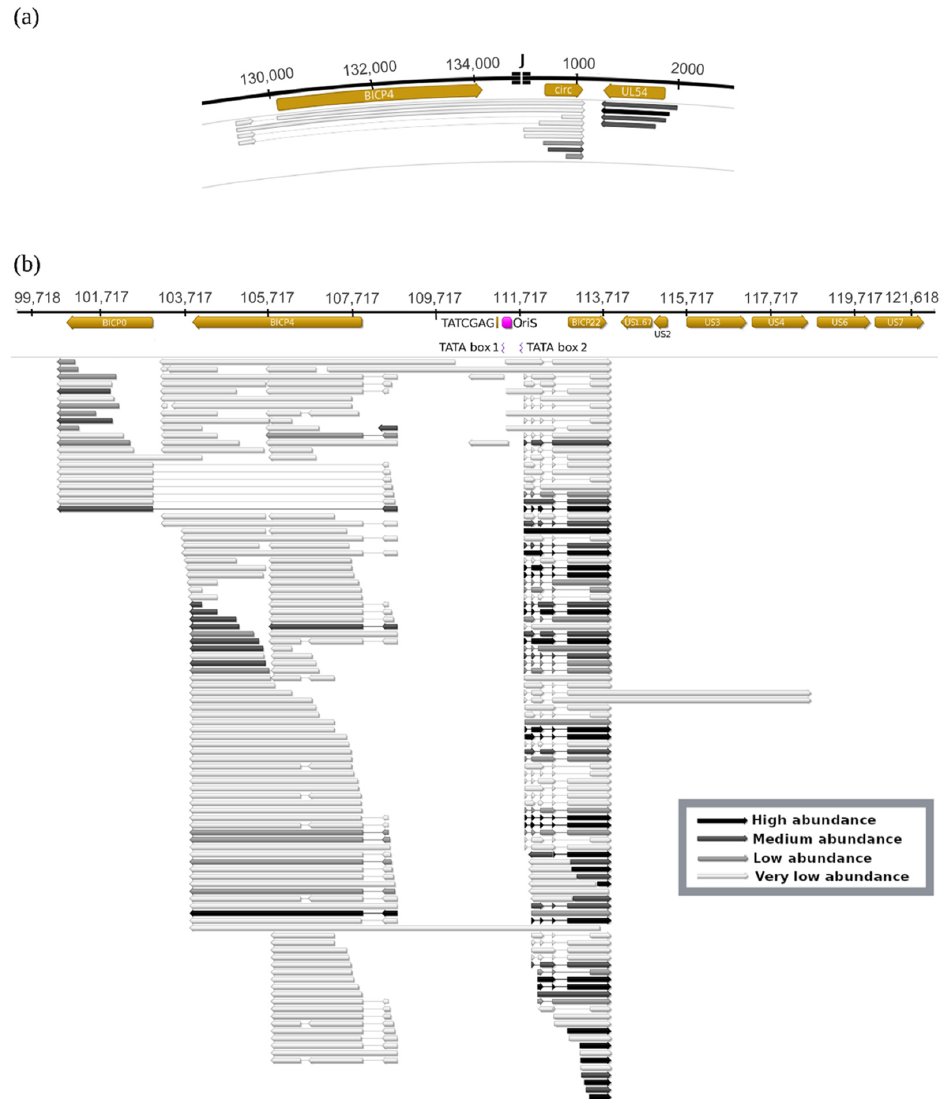
Figure 1. BoHV-1 transcripts generated from the genomic locations of IE genes. ( a ) In the circular BoHV-1 genome, the bicp4 gene occasionally produces both spliced and unspliced readthrough transcripts, which, besides the bicp4 gene, contain the circ gene located at the other terminus of the linear viral genome. Thus, the circ gene expression is partly under the control of the immediate–early bicp4 promoter. ( b ) The three immediate–early genes produce a large variety of spliced and unspliced transcripts. The bicp4 gene codes for 3 ′ -truncated non-coding RNAs and alternative TESs as well. The expression of a significant fraction of bicp0 transcripts is controlled by the icp4 promoter. The bicp22 gene exhibits the most complex expression pattern among the BoHV-1 genes, due to its use of multiple splice sites, TSSs and TESs, as well as very long transcriptional read-throughs. TATA box2 is the basal promoter of the canonical transcripts, while TATA box1 is located within the OriS. The TAATCGAT sequence is supposed to be the VP16 binding site of the promoter. Transcript abundances are indicated by color code in the figure: as the two extremes, black arrows indicate high abundance, whereas white arrows indicate low abundance transcripts.